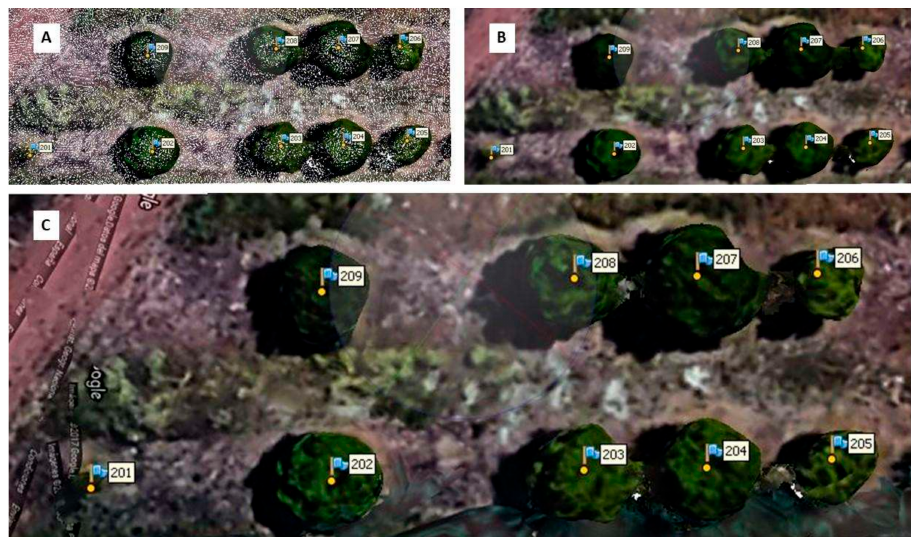
Figure 13. Model from GM. ( A ) High-density point cloud. ( B ) Clipped point cloud. ( C ) Textured